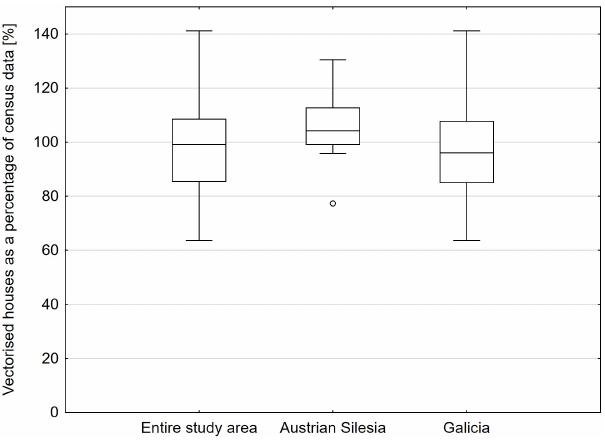
Figure 6. Number of vectorized residential structures compared to the census data at the district level for the entire study area ( n = 99), Austrian Silesia ( n = 23), and Galicia ( n = 76). Table 3. Comparison of the number of houses with the statistics presented in the map frames (number of houses according to the map frame =